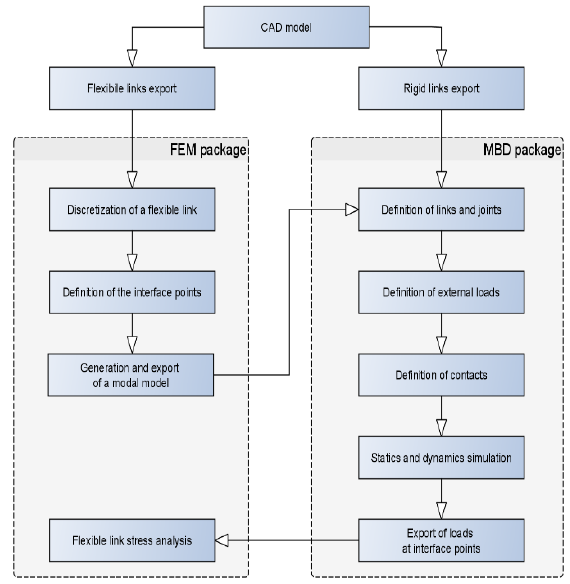
Figure 5. MSC.Adams-ANSYS interface.